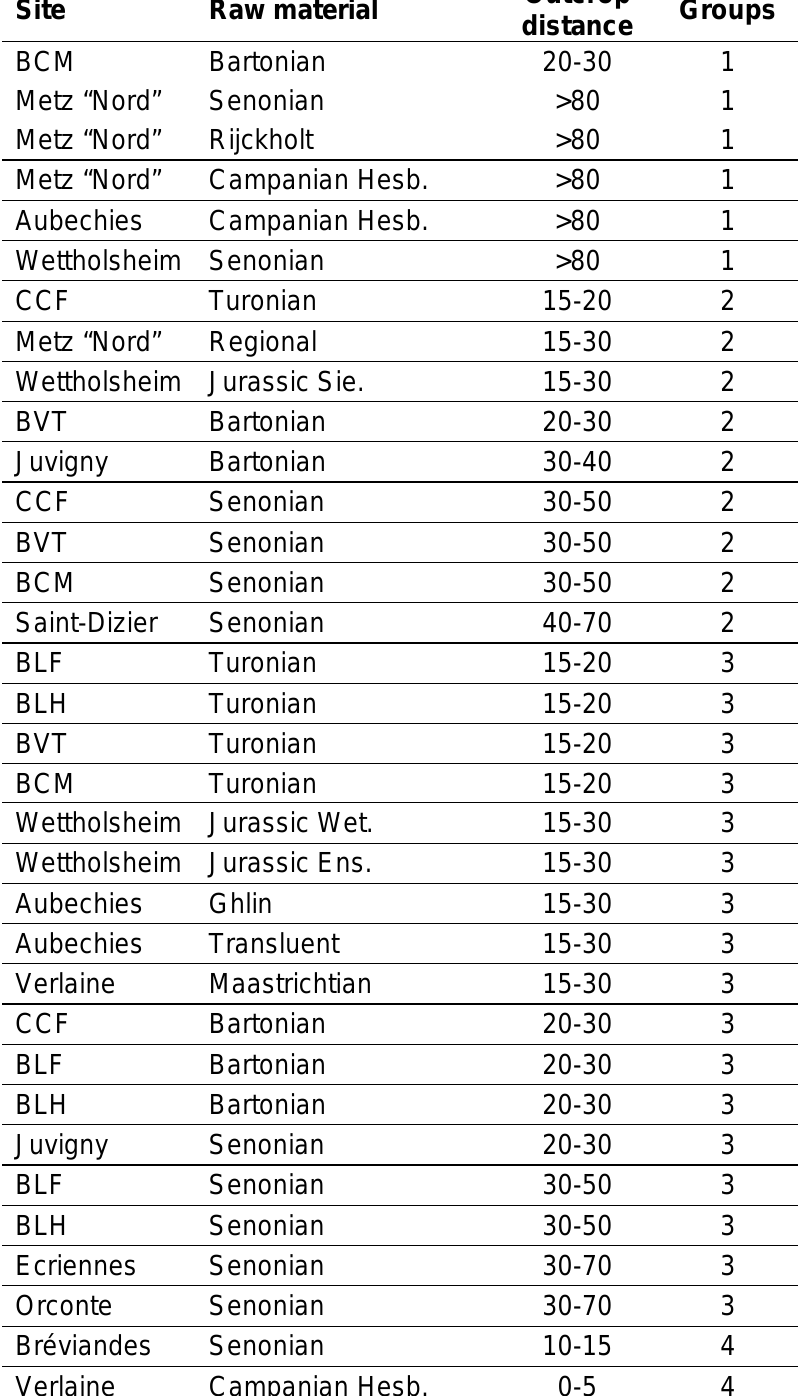
Table 1. Classification by techno-economic groups of the studied sites according to the distance to the outcrops of the main raw materials identified at these